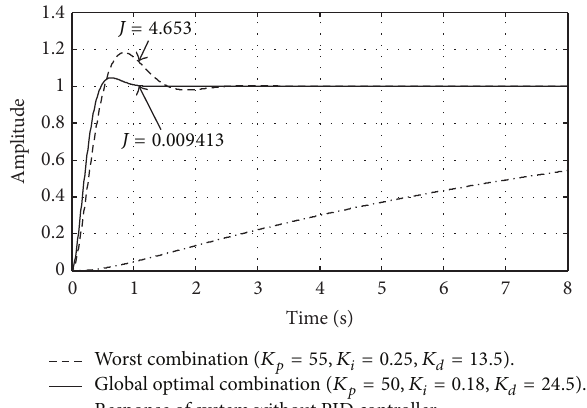
Figure 6: Step response of the optimal and worst combination PID parameters.